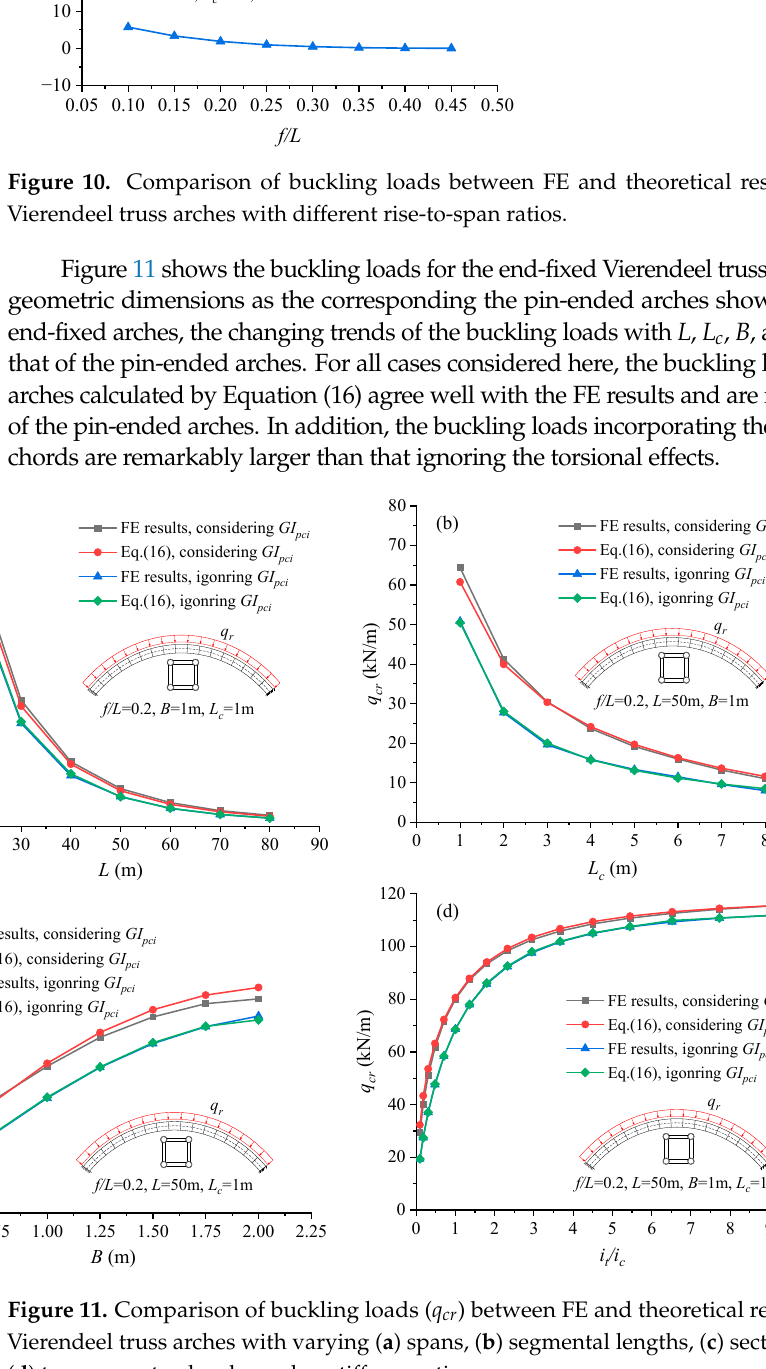
Figure 11. Comparison of buckling loads ( q cr ) between FE and theoretical results for the end-fixed Vierendeel truss arches with varying ( a ) spans, ( b ) segmental lengths, ( c ) sectional side lengths, and ( d ) transverse-to-chord member sti ff ness ratios .